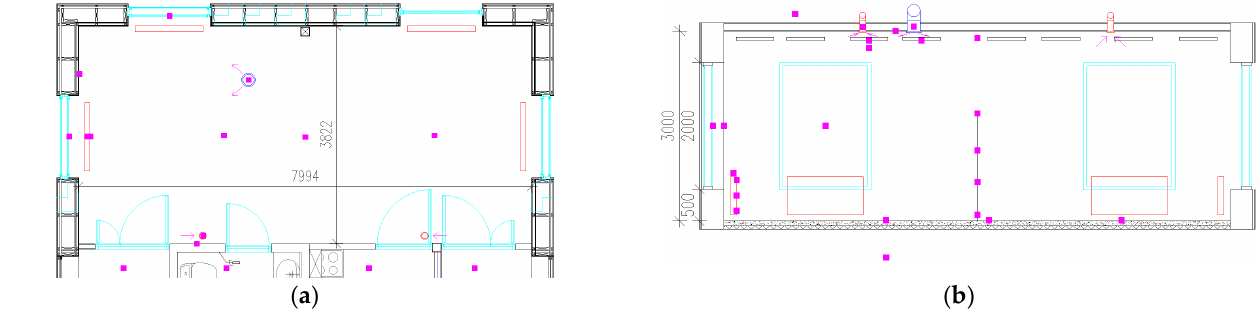
Figure 5 . Plan view of installed sensors ( a ); vertical section of the installed sensors ( b ).